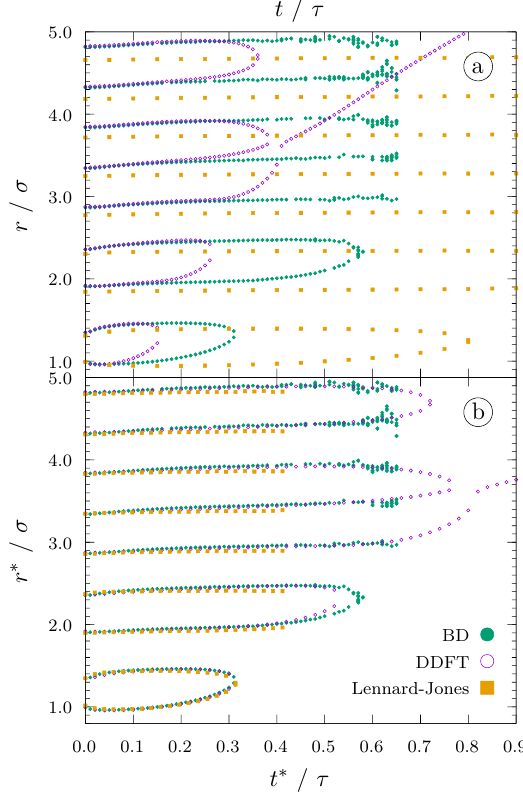
(cid:128) G (cid:138) ( r , t ) − 1 d Figure 4: Zeros of r as a function of time. Data from BD simulation ρ B (green, suppressed for t > 0.65 τ due to noise), DDFT with the quenched functional (purple), and results for the Lennard-Jones liquid (yellow). Panel (a) shows the data unmodified, whereas in panel (b), time t and distance r have been rescaled to allow for a comparison of the qualitative behaviour. Here the rescaled quantities are marked by an asterisk and the rescaling is such that t = t ∗ , r = r ∗ for hard sphere BD simulation, 2 t = t ∗ and r = r ∗ for hard sphere DDFT, and t / 2.55 = t ∗ and 1.03 r = r ∗ for the Lennard-Jones